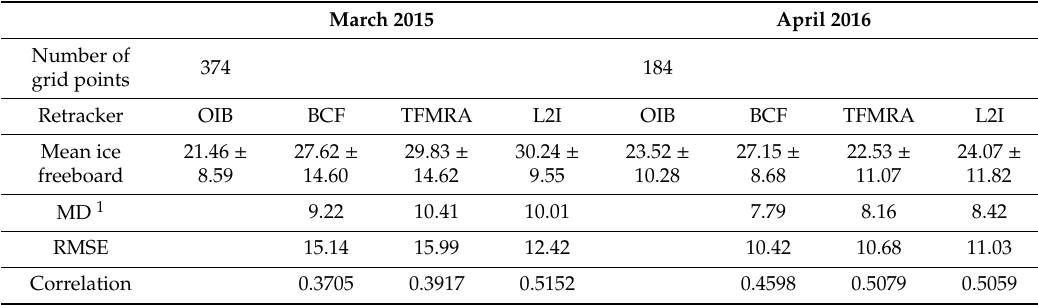
Table 5. CS-2 ice freeboard retrievals from the BCF, TFMRA, and CS-2 L2I products compared to